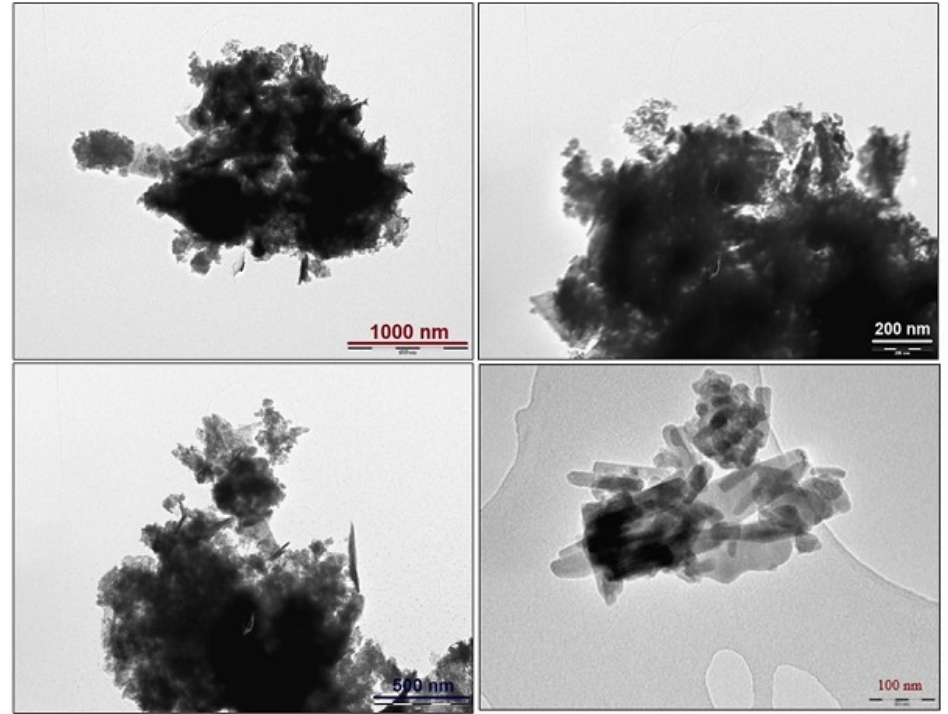
Figure 5. TEM micrographs of Na 2 CaP 2 O 7 nanopowder.